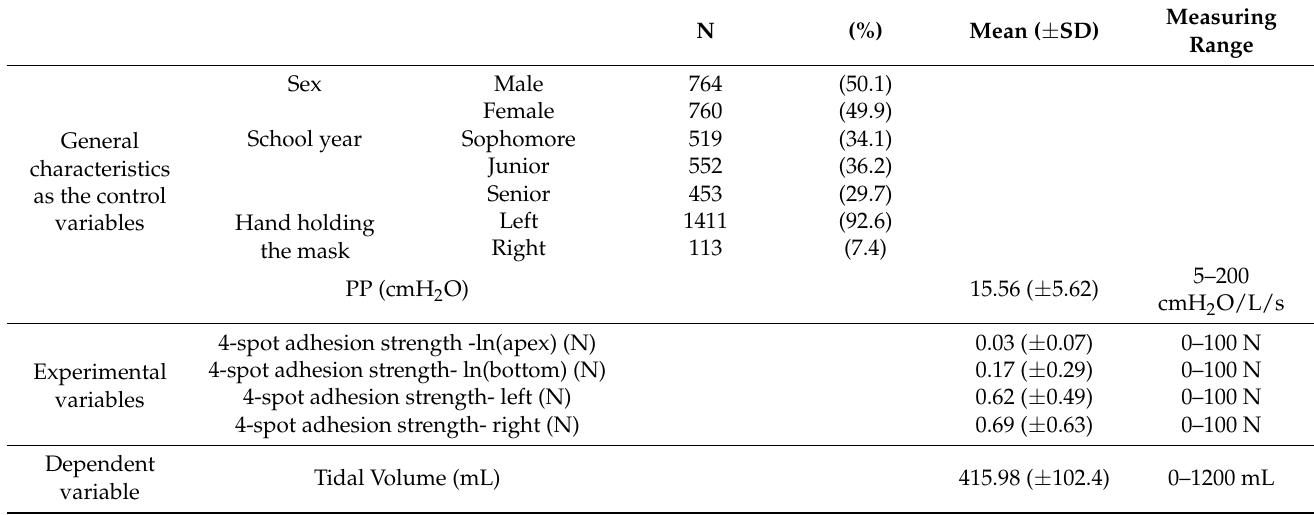
Table 2. The mean and range of the study main variables, N =